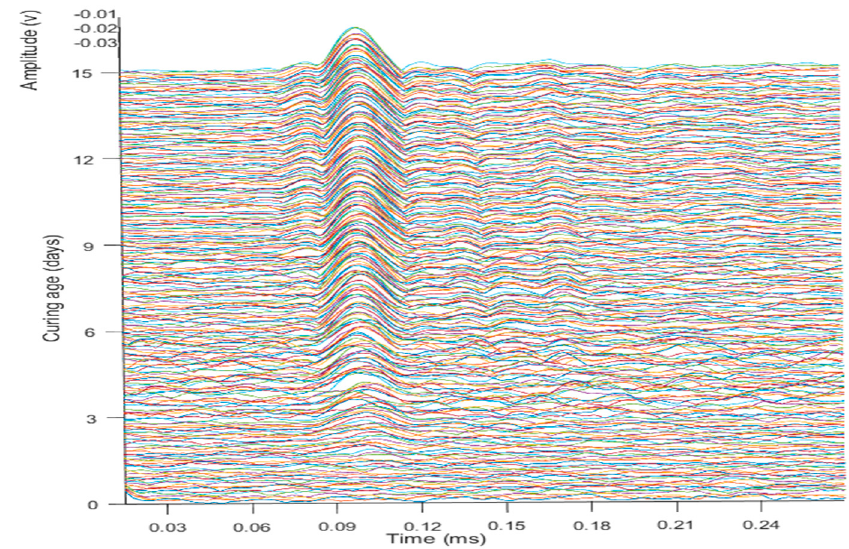
Figure 12. Amplitude rise pattern with curing time for ultrasonic waves data.